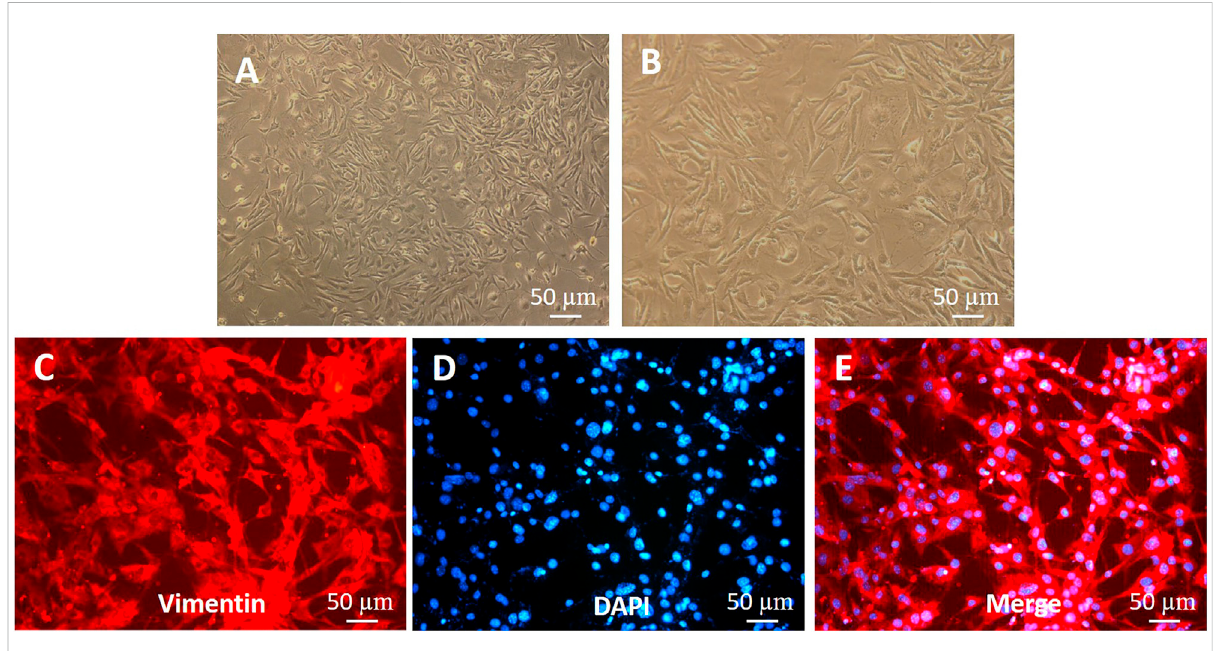
FIGURE 4 Identi fi cation of fi broblasts (A,B) Morphology of fi broblasts. (C – E) Vimentin expression in fi broblasts (immuno fl uorescence staining). The shorter scale bar represents 50 μ m, the middle scale bar represents 100 μ m, and the longer scale bar represents 50